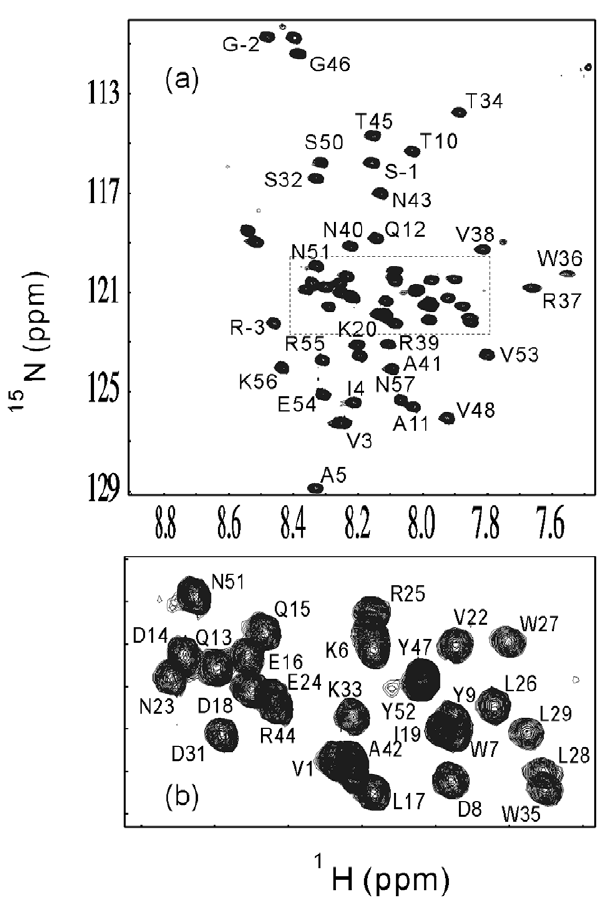
Figure 4. NMR sequential assignment. 1 H- 15 N NMR HSQC spectrum of V22-SH3 with a protein concentration of , 800 m M dissolved in salt- free water (pH 4.0) acquired on an 800 MHz NMR spectrometer at 25 u C. The assigned residues are labelled in the full (a) and expanded spectra (b).